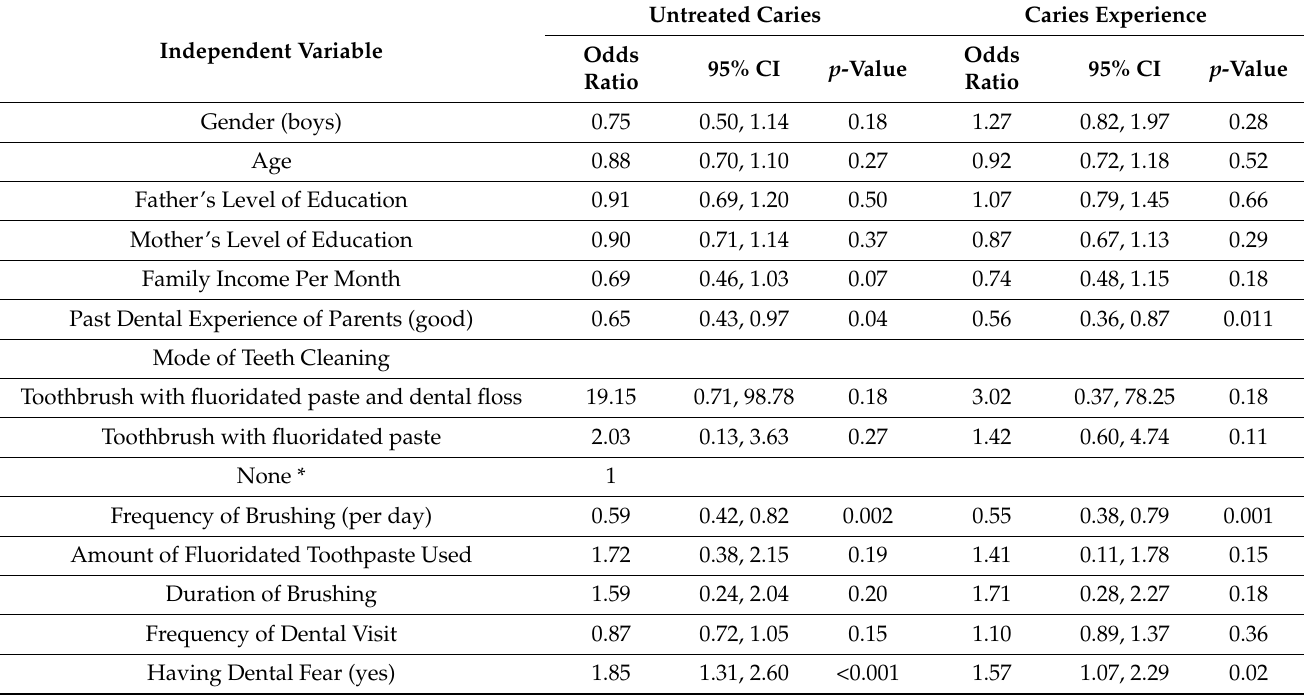
Table 4. Binary logistic regression models demonstrating the association between dental caries status and dental caries experience with various independent variables.